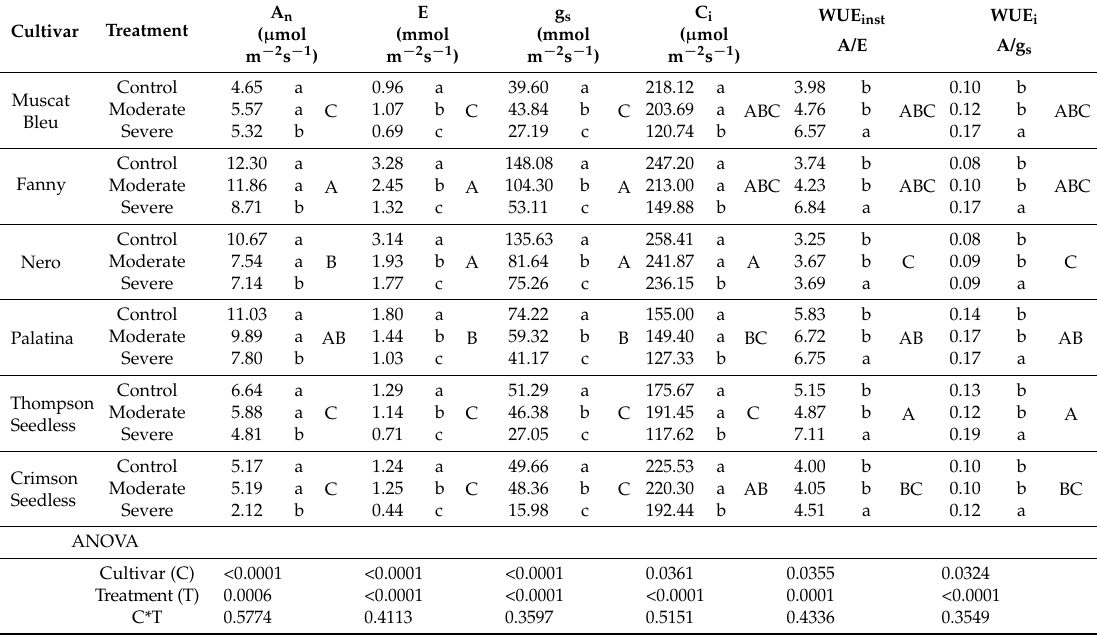
Table 2. Mean values of net assimilation (A n ) and intercellular CO 2 (C i ), and median values of transpiration (E), stomatal conductance ( g s ), and leaf-level water use efficiencies (intrinsic: WUE i and instantaneous: WUE inst ) of six table grape cultivars subjected to three water deficit